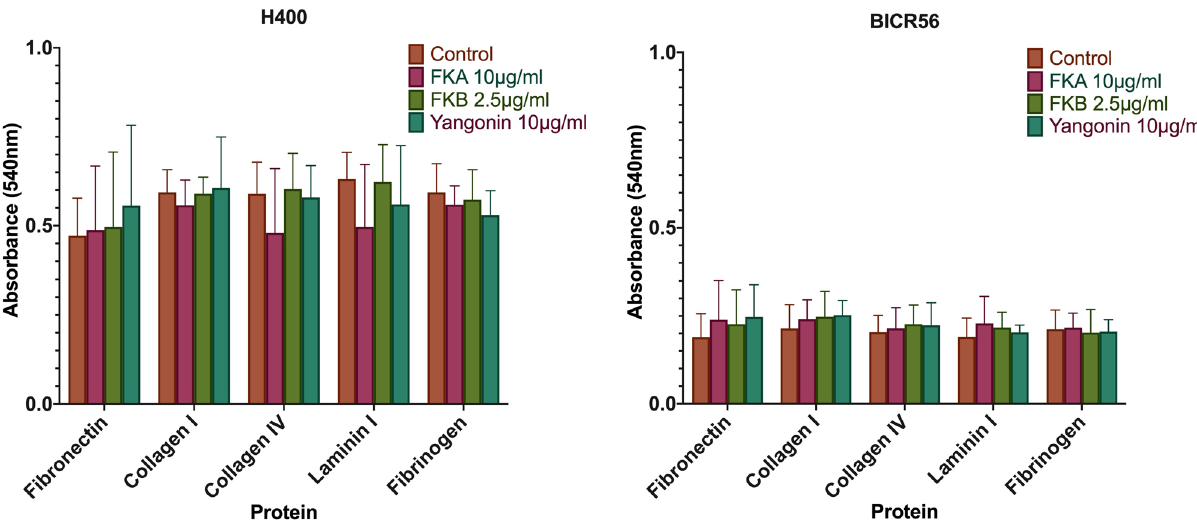
Figure 6. Adhesion assay. the effect of 10 μg/ml FKA, 2.5 μg/ml FKB and 10 μg/mL yangonin on H400 and BICR56 cells. Data are represented as mean ± SD. Statistical significance is given as follows: * p < 0.05, ** p < 0.01, *** p < 0.005, **** p < 0.001; compared to control